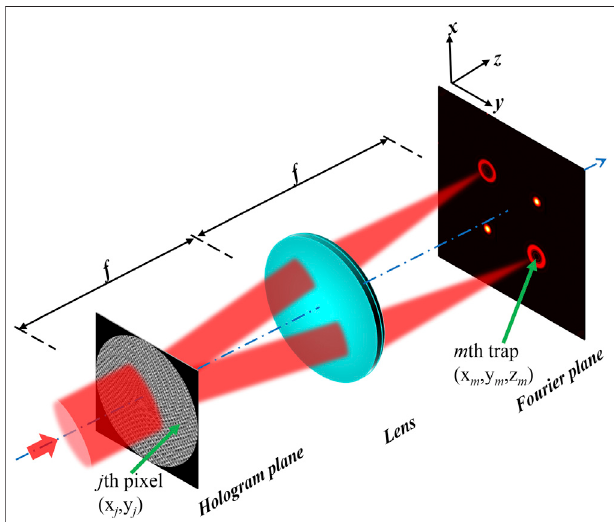
FIGURE 1 | Schematic diagram of holographic beam shaping.